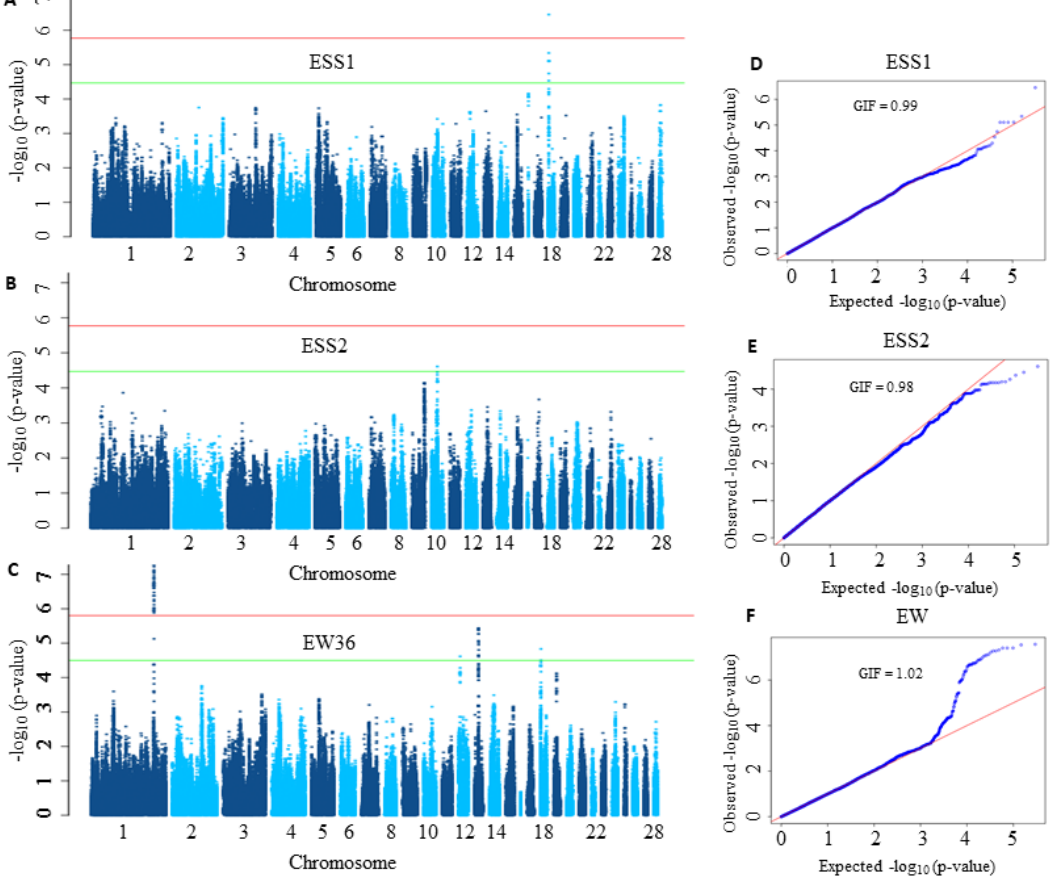
Figure 2. Manhattan and Q-Q plots corresponding to eggshell strength at time point 1 (ESS1), time point 2 (ESS2) and egg weight at 36 weeks of age (EW36). In Manhattan plots ( A – C ), the horizontal red and green lines denote the genome-wide significance ( p -value = 1.7 × 10 − 6 for ESS1 and ESS2 and 1.5 × 10 − 6 for EW36) and suggestive significance thresholds ( p -value = 3.4 × 10 − 5 for ESS1 and ESS2 3.1 × 10 − 5 for EW), respectively. The − log10 of the observed p -values for each single nucleotide polymorphism (SNP) is given on the y-axis while its position on a chromosome is given on the x-axis. In Q-Q plots ( D – F ) the observed − log10 transformed p -values are plotted against the expected − log10 transformed p -values. GIF stands for genomic inflation